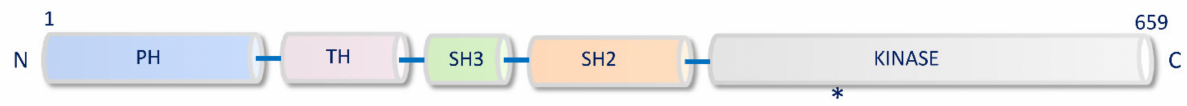
Figure 1. Schematic representation of the 659 amino acid BTK structure. BTK has five domains. The pleckstrin homology domain (PH) has phospholipid binding ability, which allows for the recruitment of BTK from the cytosol to the plasma membrane. The Tec homology domain (TH) plays an essential role in BTK stabilization. The Src domains (SH3 and SH2) are involved in protein–protein interactions. The kinase domain is the catalytic part of the protein. Each domain interacts with different signaling molecules. * Indicates the cysteine-481 residue position in the kinase domain, which is the site for covalent binding of the BTK irreversible